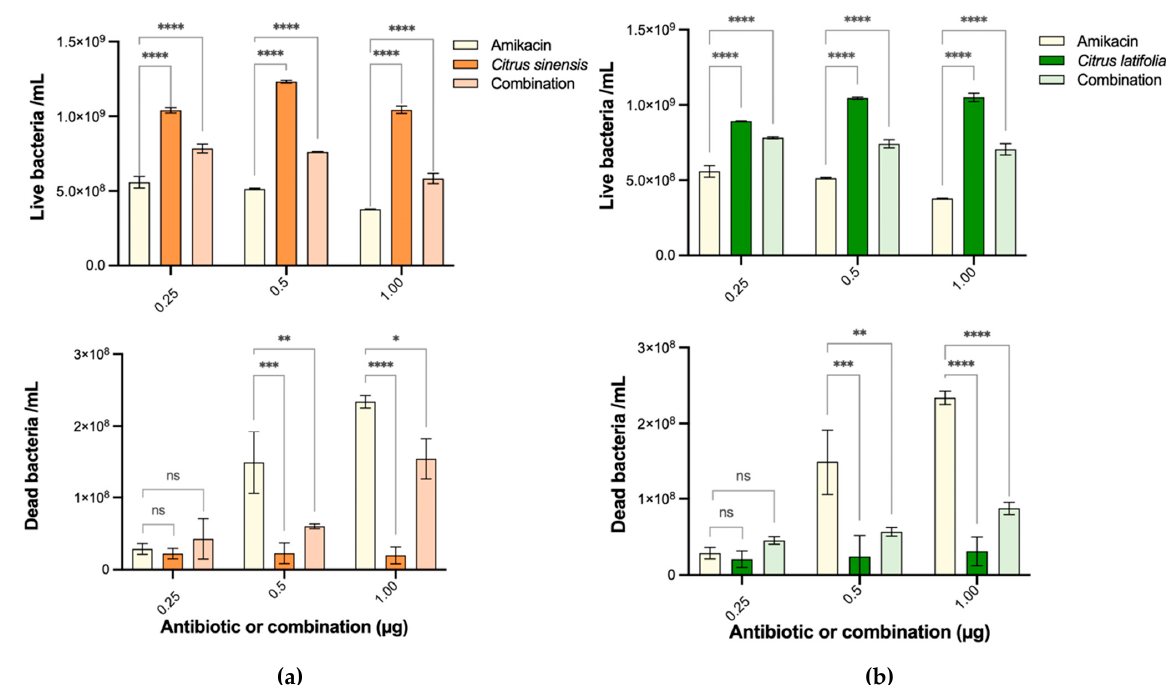
Figure 8. Evaluation of EOs combination with antibiotic. ( a ) Bar graph of the number of live and dead cells calculated from FC acquired gates for C. sinensis combined with amikacin. ( b ) Bar graph of the number of live and dead cells calculated from FC acquired gates for C. latifolia in combination with amikacin. Bars are expressed as mean ± S.D. 2-way ANOVA: ns = p > 0.05, * p ≤ 0.05; ** p ≤ 0.01; *** p ≤ 0.001; **** p ≤ 0.0001.